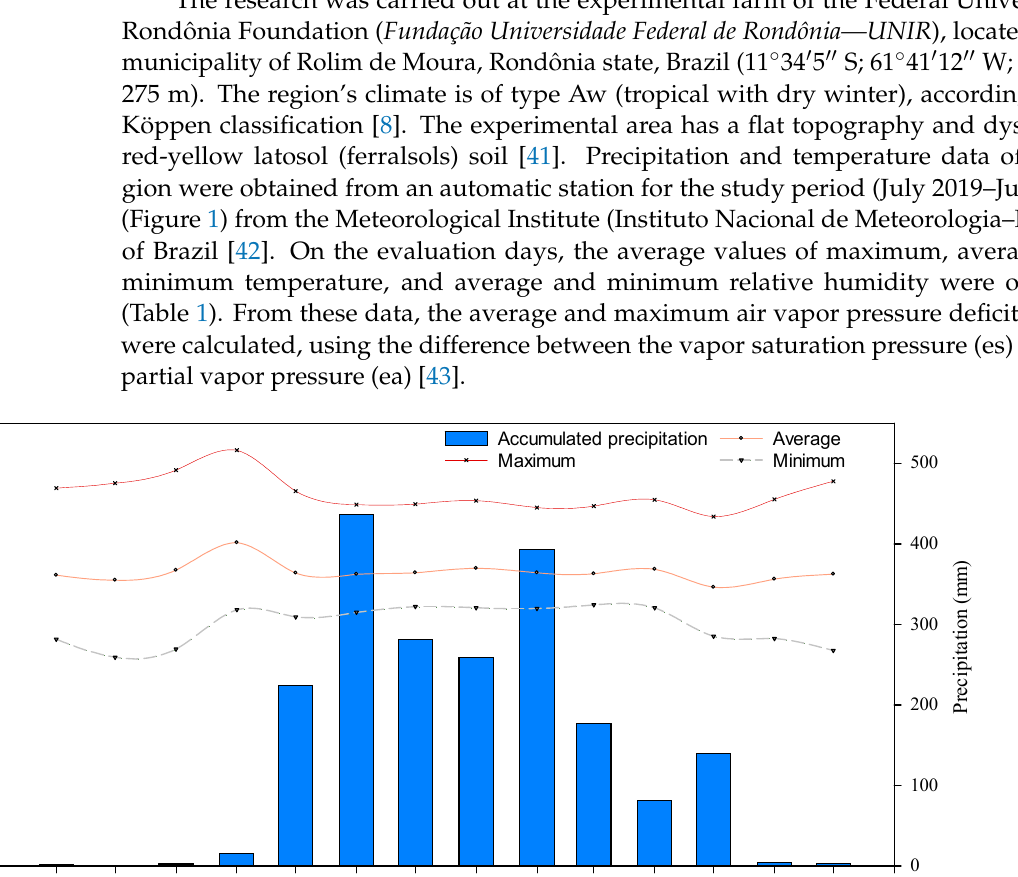
Figure 1. Accumulated precipitation data (blue) and minimum (grey), average (orange) and maximum (red) mean temperatures of the region during the experimental period. Table 1. Climatic data of the region during the assessments. Average of daily mean values. Rel. Air Humidity (%) Season